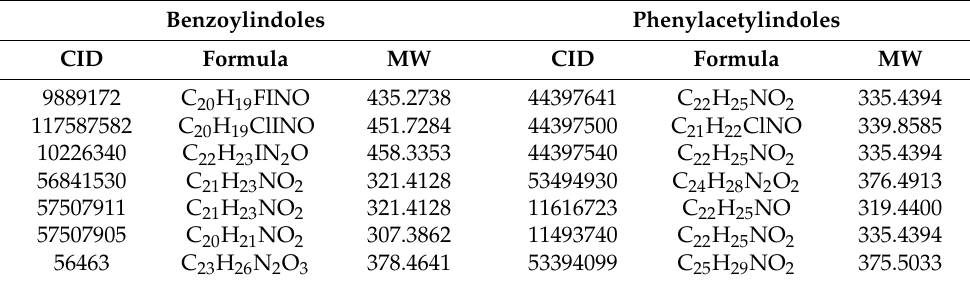
Figure 3. The structures of the studied molecules from ( a ) Group 1 and ( b ) Group 2. Table 1. The CID, molecular formula, and MW of the studied drugs.